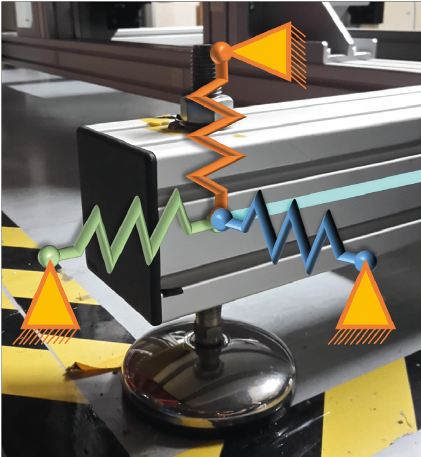
Figure 5: Levelling foot that supported the OTS. Superimposed, its modelling approach (three linear springs).